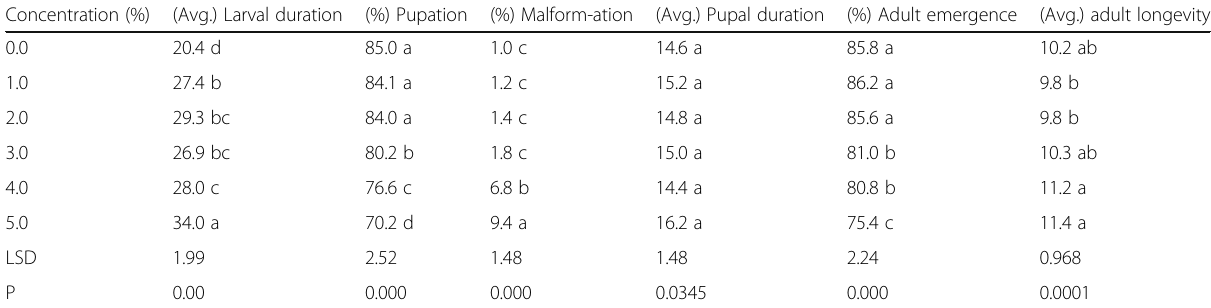
Table 3 Effect of orange oil concentrations on certain reproductive biology of Spodoptera littoralis treated as second instar larvae Concentration (%) (Avg.) Larval duration (%) Pupation (%) Malform-ation (Avg.) Pupal duration (%) Adult emergence (Avg.) adult longevity